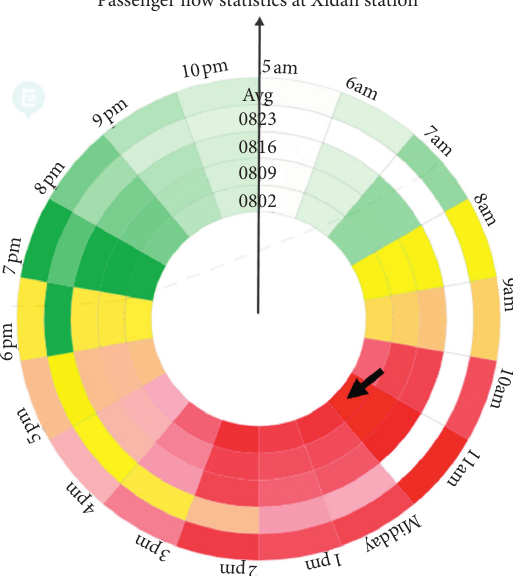
Figure 7: The verification view: verification of passenger flow anomalies at Xidan station on August